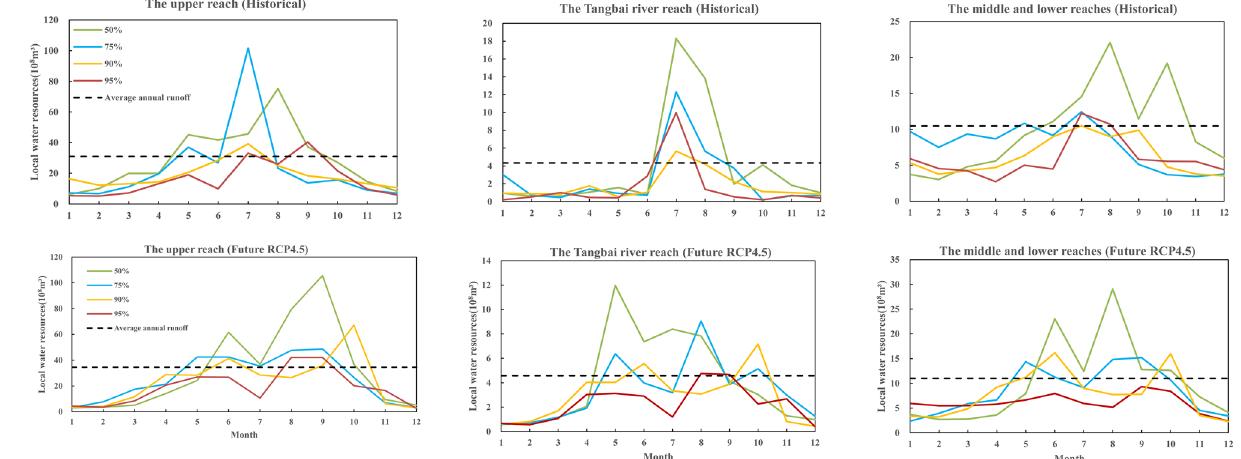
Figure 5. Local water resources under different inflow frequencies in history and future.